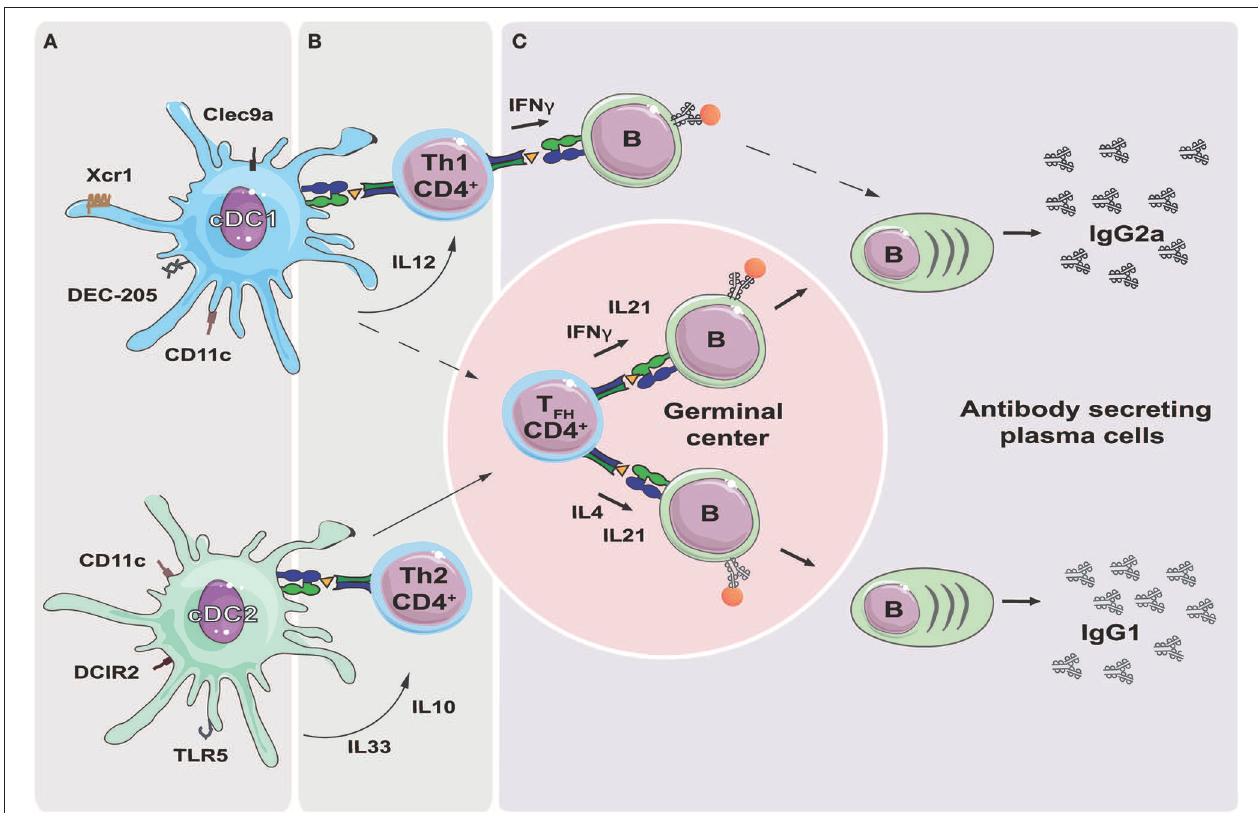
FIGURE 1 | Targeting DC subsets to influence the polarization of the antibody response. (A) Targeting the receptors Xcr1, Clec9a and DEC-205 can be used to deliver antigen to cDC1s, while targeting DCIR2 and TLR5 will deliver antigen to cDC2s. Targeting CD11c will deliver antigen to both DC subsets. (B) Delivery of antigen to cDC1s or cDC2s will result in presentation of antigen derived peptides on MHC-II. Secretion of cytokines such as IL-12 by cDC1s, or IL10 and IL33 by cDC2s, can initiate polarization of the T helper cell responses in direction of Th1 or Th2, respectively. In addition, both cDC1s and cDC2s have been reported to induce T FH cells, although cDC2s are likely more important in this respect. (C) T FH cells migrate to germinal center where they regulate isotype switching of antigen specific B cells through secretion of IFN γ (IgG2a) or IL4 (IgG1). Th1 may also contribute to isotype switching through secretion of IFN γ , while it is less clear if Th2 cells contribute to IgG1 switching by secretion of IL4. T FH cells further regulate affinity maturation of the antigen specific B cells, and secrete IL-21 resulting in the formation of plasma cells and secretion of high affinity